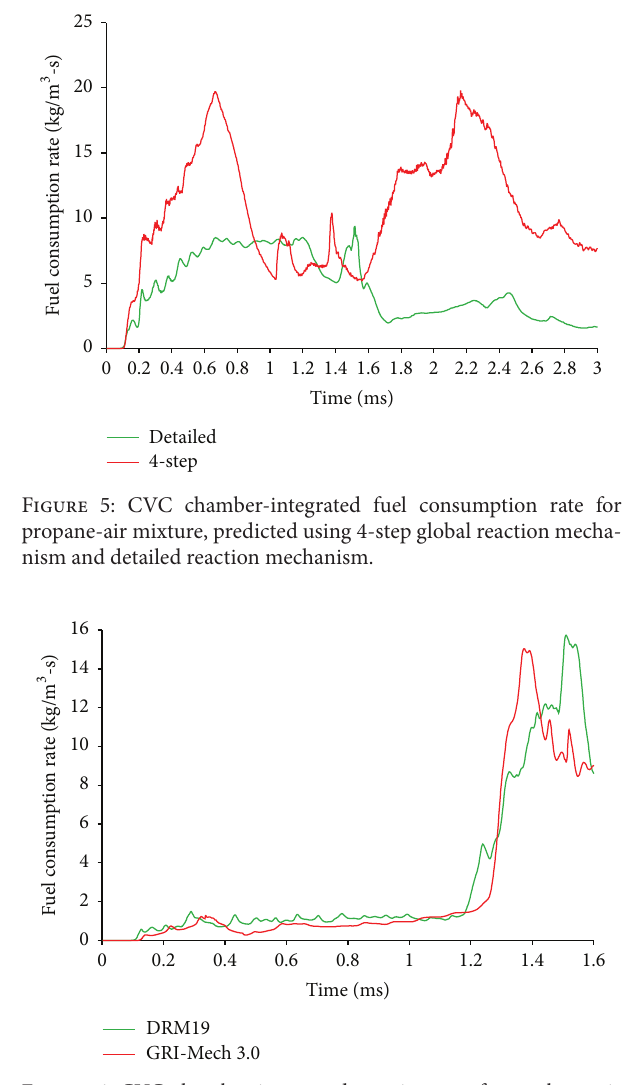
Figure 6: CVC chamber-integrated reaction rate for methane-air mixture, predicted using GRI-Mech 3.0 and